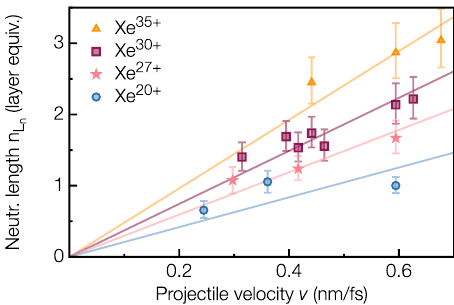
Fig. 5 Neutralisation velocity. Comparison of the characteristic neutralisation velocities v n calculated from two approaches: variation of projectile velocity for one layer of material (Fig. 2, v n , v , green squares) and variation of the number of layers for speci fi c energies (Fig. 4, v n ; n circles). The uncertainty stems from the difference in fi tting parameters considering the extreme cases of errors for the data presented in Figs. 2 and 4, respectively. A linear fi t incorporating all data points is added in blue and given in Eq. (3). Coloured areas above and below this line, respectively, indicate charge state/velocity combinations that will lead to neutral (blue) or still charged (orange) particles after transmission through a single layer of